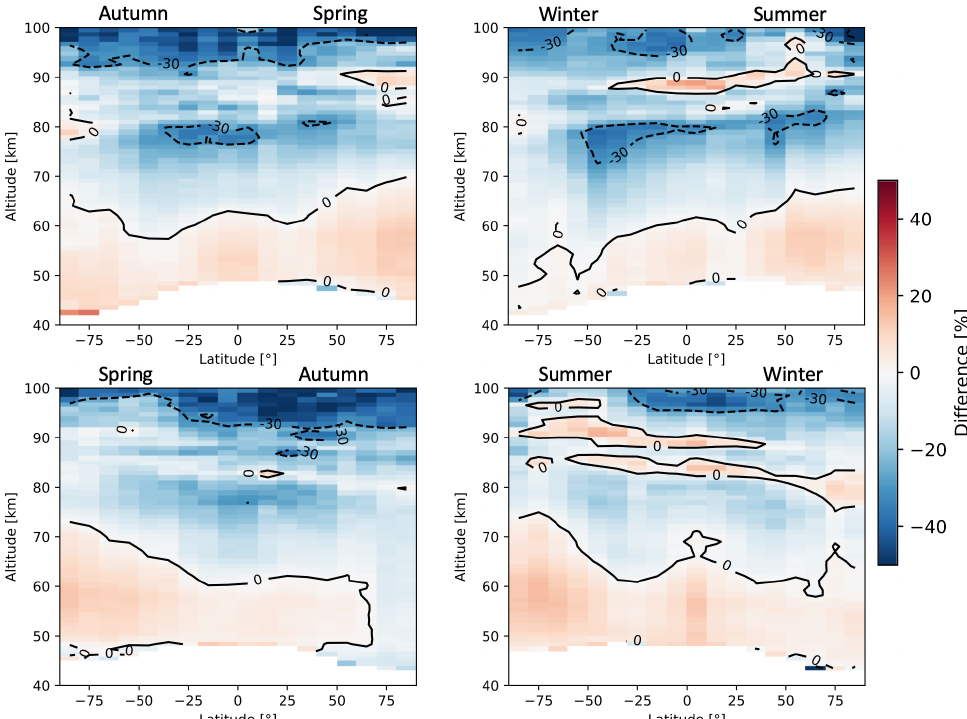
Figure A6. Seasonal zonal means of H 2 O FM19 SMR v3.0–v2.1 relative differences averaged over the whole time period between February 2001 and April 2019. The seasons are intended as astronomical seasons, i.e. each starting at the respective solstice or equinox. Atmos. Meas. Tech., 14, 5823–5857,